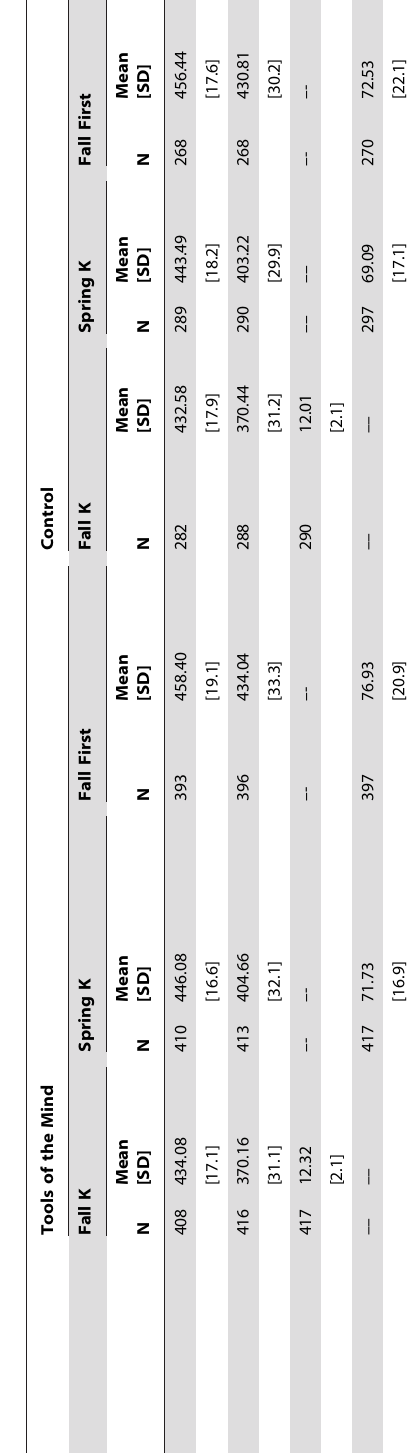
For outcome assessments with three time points, namely, measures of cortisol and alpha amylase, and mathematics and reading ability with first grade data included, we added a within- person level to the model, in addition to child and school levels. In these models we examined treatment effects on the linear slope as well as the intercept. For the prediction of math and reading outcomes, the intercept was set at the last time point, first grade. Effect sizes were calculated as the covariate adjusted model parameter estimate for the binary treatment versus control comparison divided by the pooled standard deviation for the outcome. This provides an estimate of the covariate adjusted mean difference between groups in standard deviation units. Effect sizes